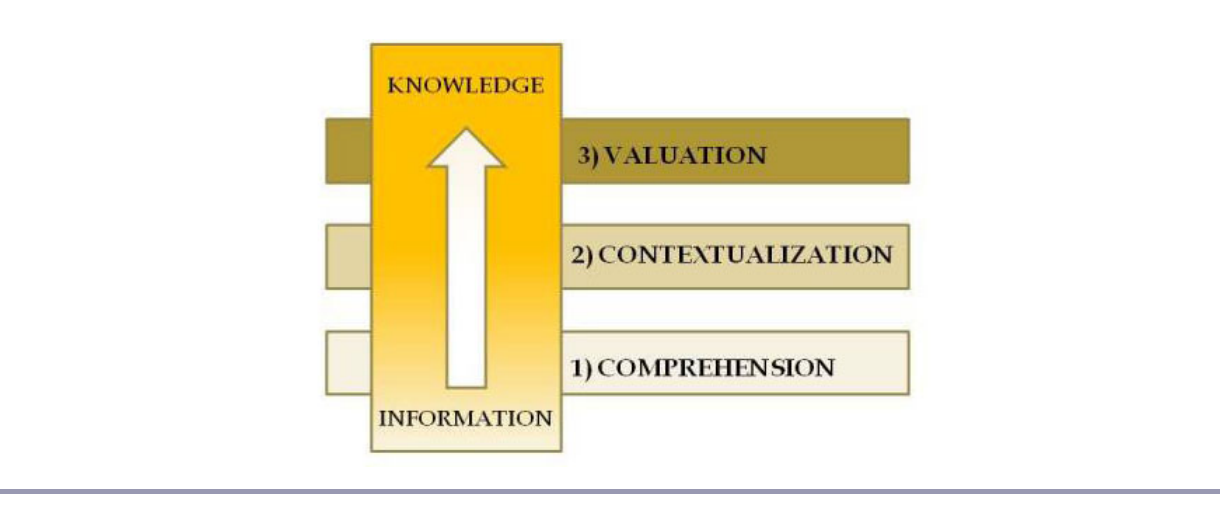
Fig. 2. The three step transformational process of knowledge production from new information, modified from Diemers